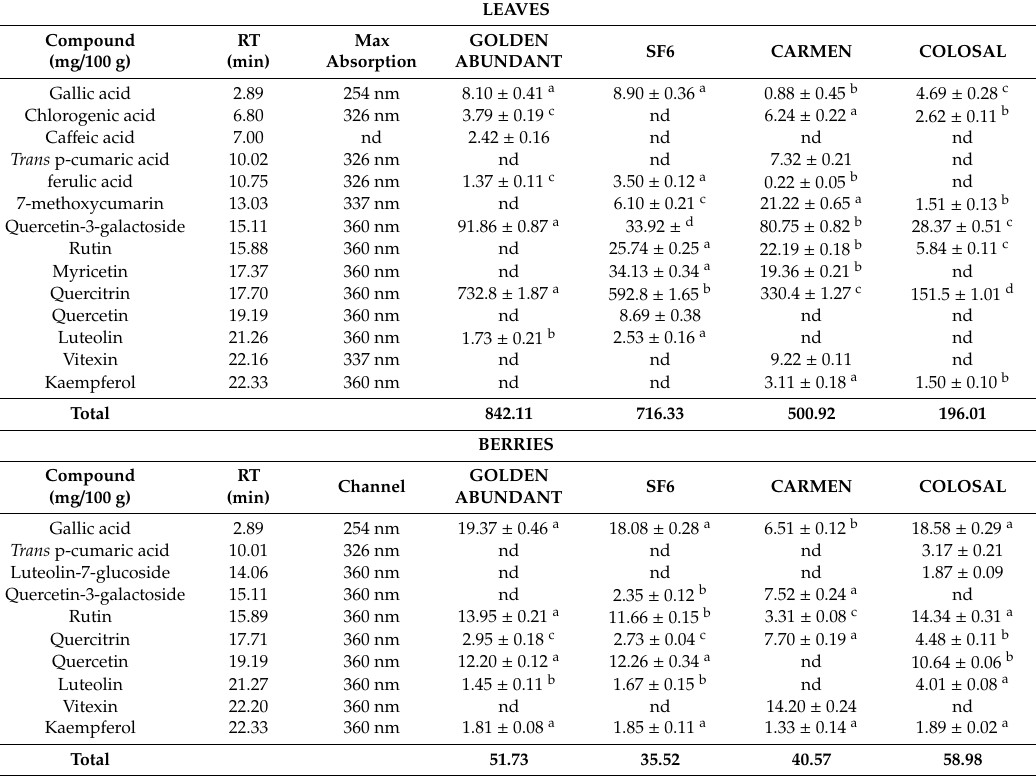
Table 3. Content of polyphenolic compounds identified in sea buckthorn extracts.